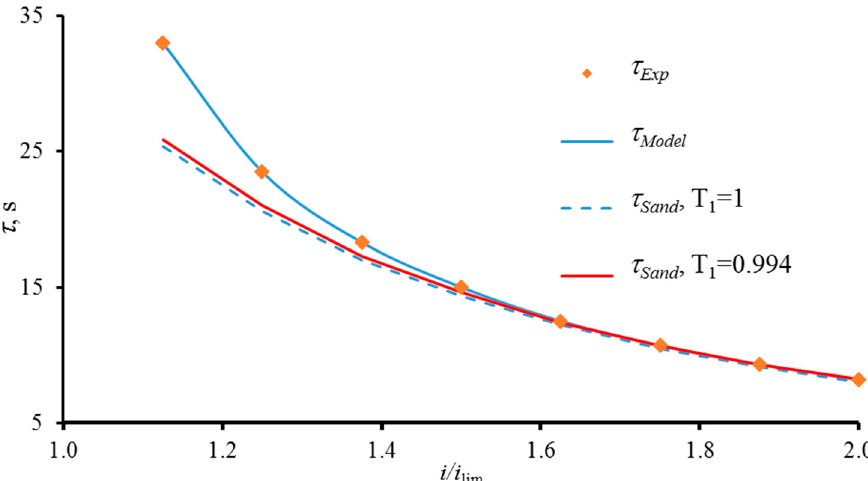
Figure 14. Dependence of theoretical (lines) and experimental (points) transition time on the normalized current density for a Neosepta ® CMX membrane in a 0.02 M NaCl, τ Sand refers to the transition time calculated using the Sand equation, Equation (76); τ Model refers to the finite-length time-dependent diffusion layer model [269]; the DBL thickness and the limiting current density calculated using the Lévêque Equations (60) and (61) are δ Lev = 260 μ m, i lim = 2.0 mA/cm 2 , respectively. Reproduced with permission from [269], Elsevier, 2016.